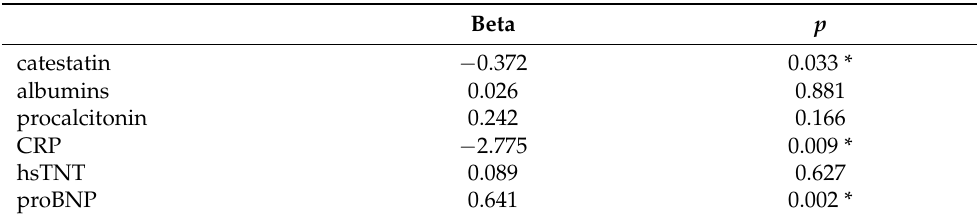
Table 6. Multiple regression model (enter method) between SOFA score as a dependent variable and CST, cardiovascular injury markers, and inflammatory markers as predictors. Beta p catestatin − 0.372 0.033 *